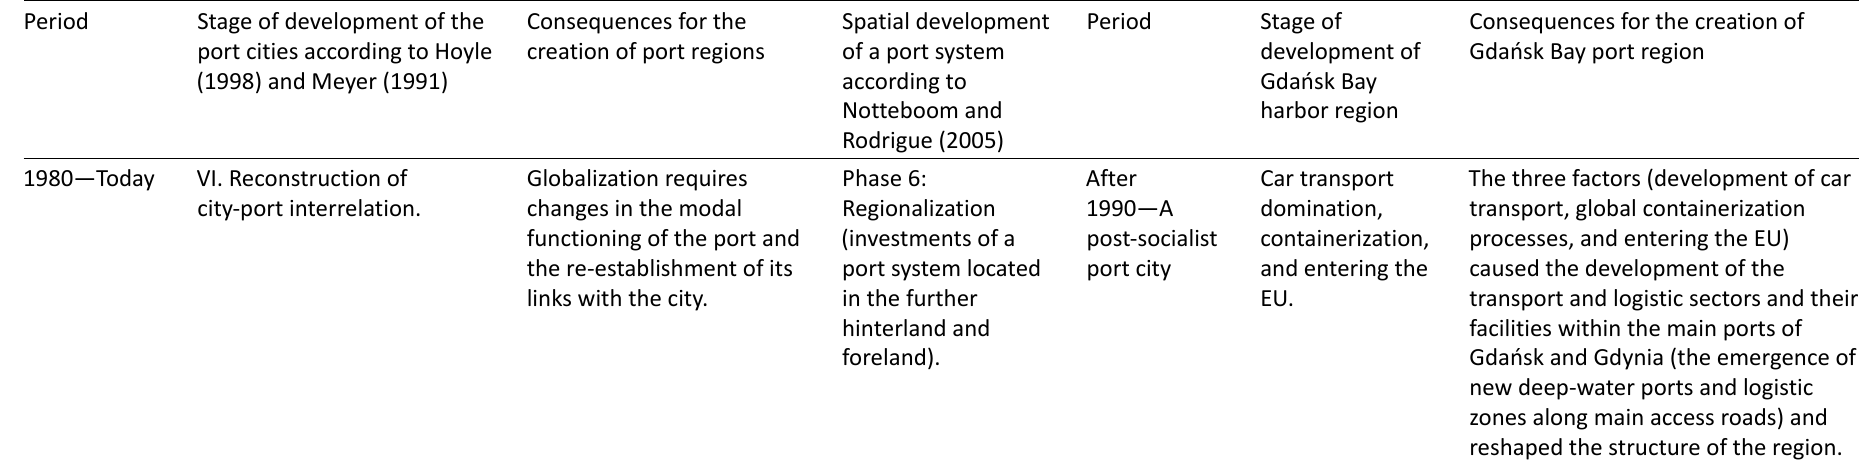
Table 1. (Cont.) Comparison of evolutionary stages of the port‐city interrelation.